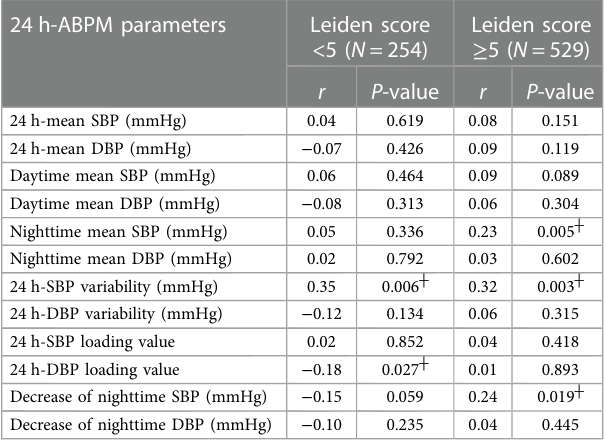
TABLE 3 Univariate correlation analysis between 24 h-ABPM parameters and Leiden